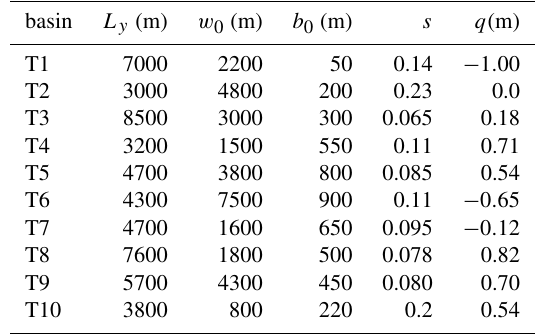
Table 2. Geometrical characteristics of the tributary basins of Monacobreen. Basin numbers as indicated in Fig.